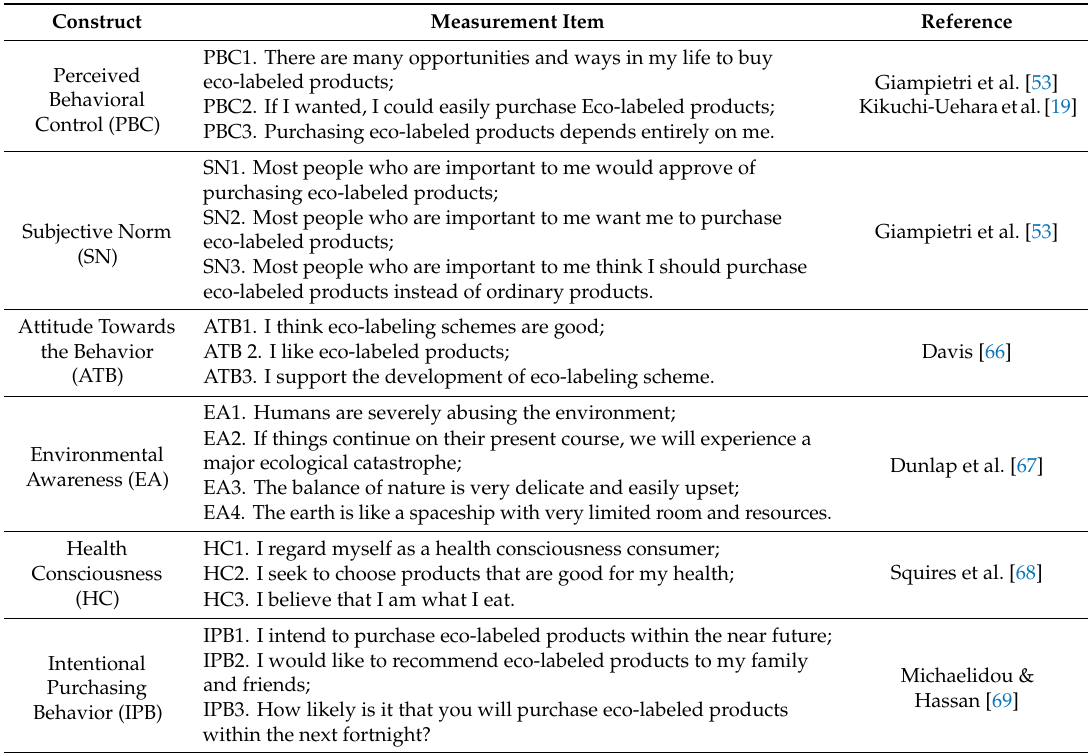
Table 1. Measurement items of